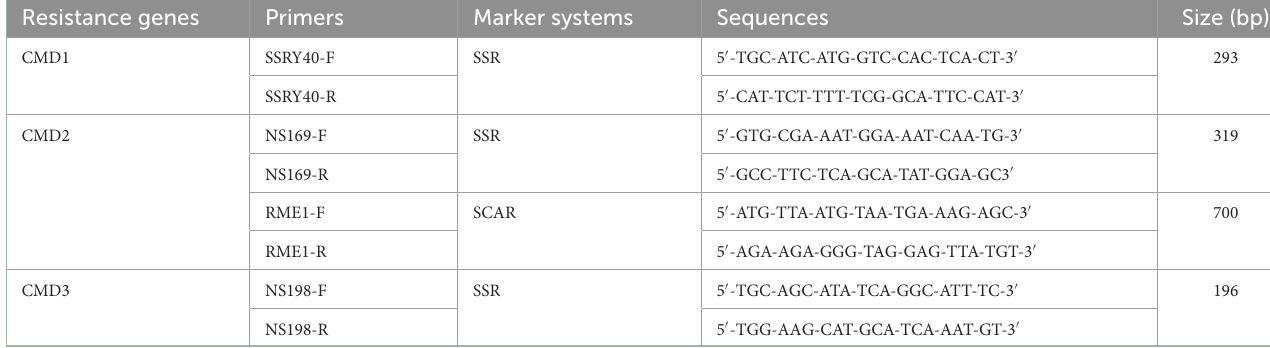
TABLE 3 PCR primers for the detection of CMD resistance